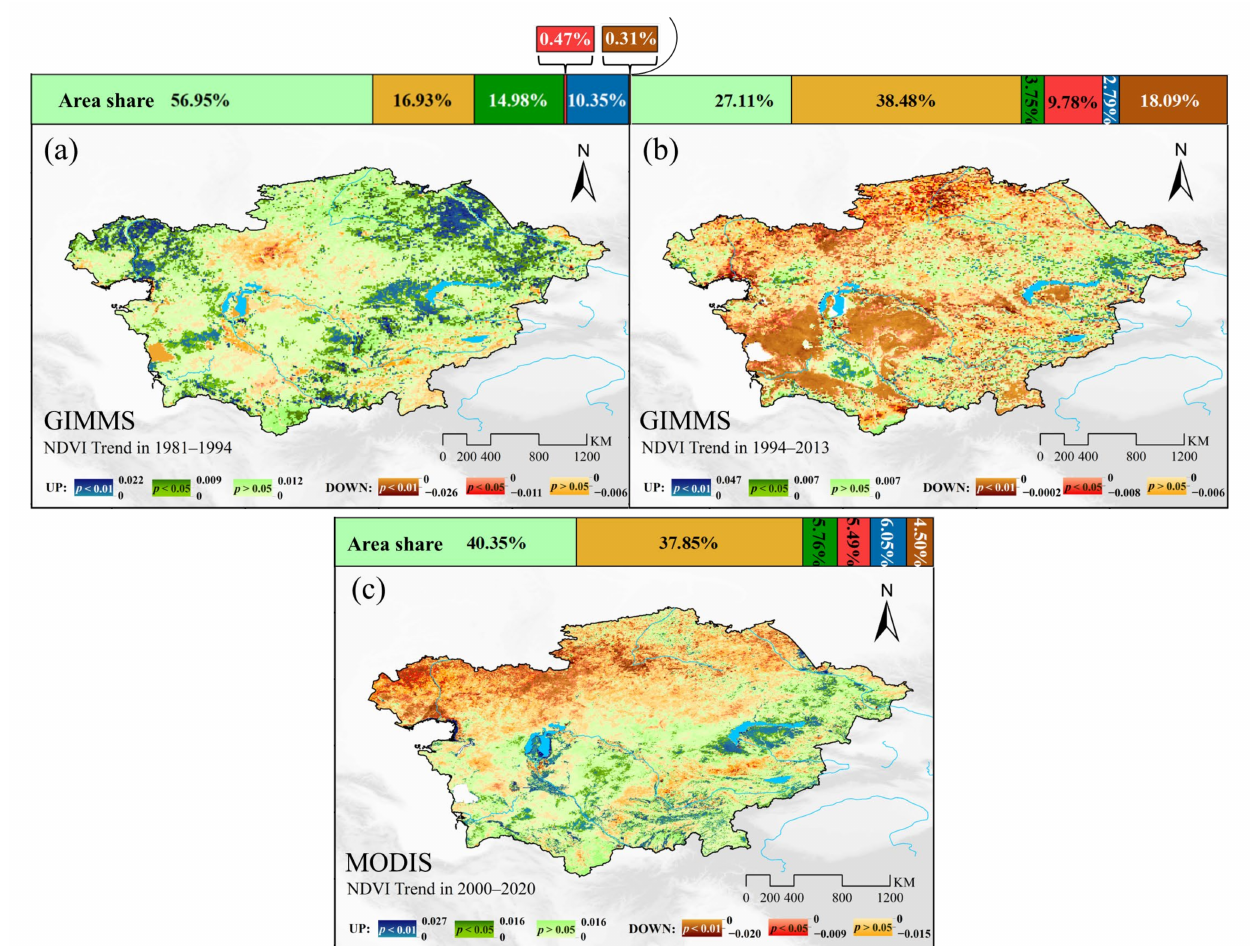
Figure 4. Spatial variation trends for NDVI: ( a , b ) the GIMMS NDVI trends before and after 1994, respectively; ( c ) the MODIS NDVI trends from 2000 to